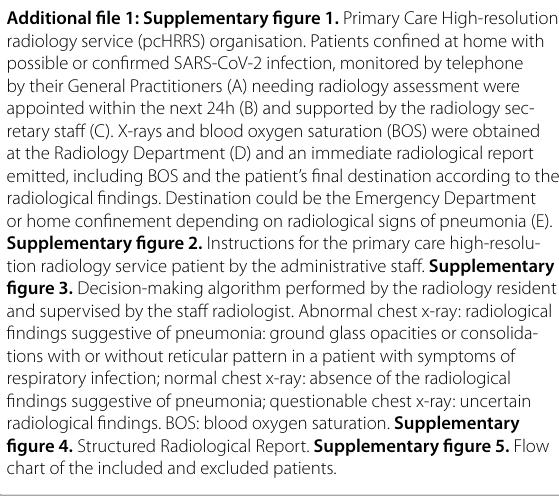
figure 3. Decision-making algorithm performed by the radiology resident and supervised by the staff radiologist. Abnormal chest x-ray: radiological findings suggestive of pneumonia: ground glass opacities or consolida- tions with or without reticular pattern in a patient with symptoms of respiratory infection; normal chest x-ray: absence of the radiological findings suggestive of pneumonia; questionable chest x-ray: uncertain radiological findings. BOS: blood oxygen saturation. Supplementary figure 4. Structured Radiological Report. Supplementary figure 5. Flow chart of the included and excluded